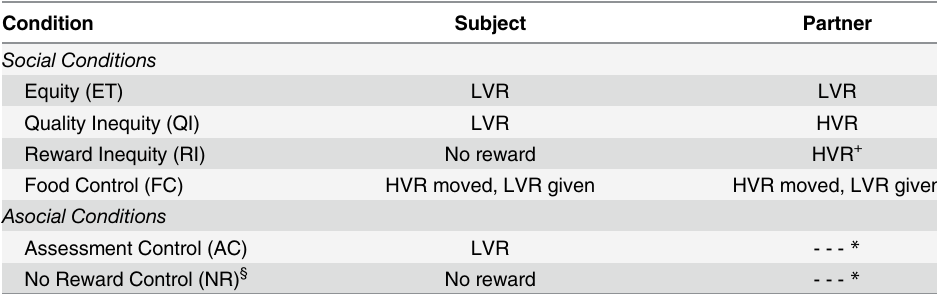
Table 2. Test conditions for paw